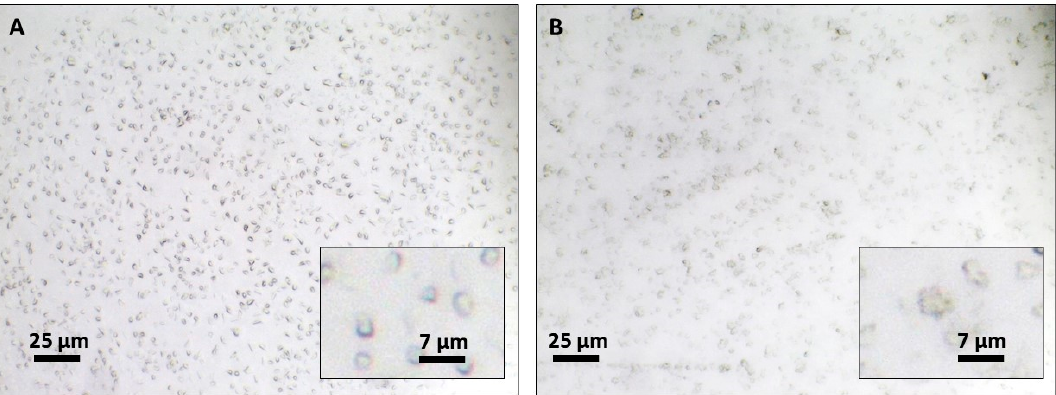
Figure 5. Optical microscopy images of the semi-solid formulation containing blank NCs (without benzophenone-3) ( A ) and containing the benzophenone-3-loaded NCs (BZP3-NCs) ( B ).